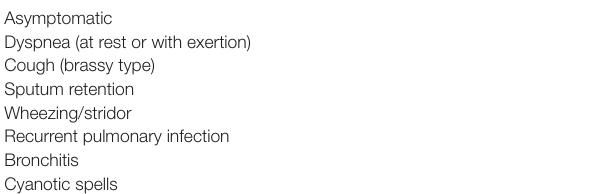
TAble 1 | Symptoms of